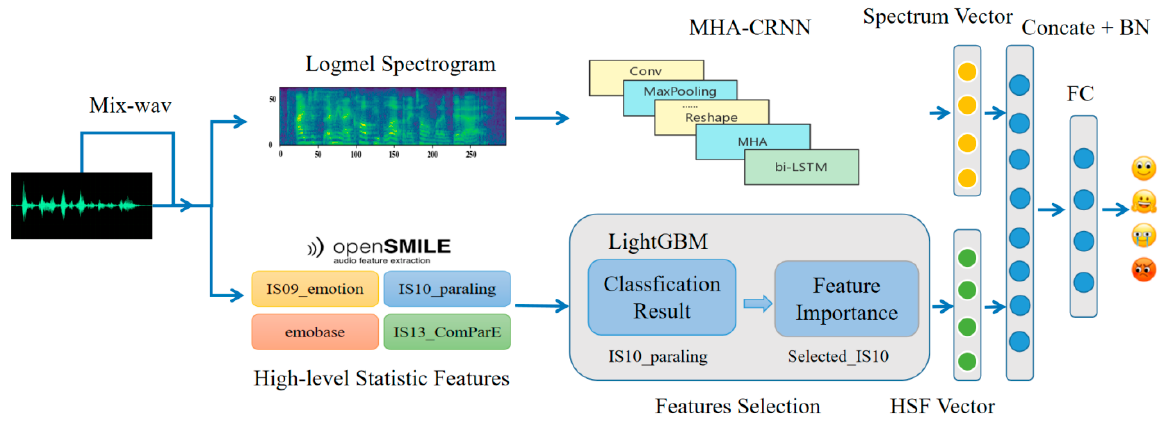
Figure 1. Proposed method. Includes data enhancement, feature extraction, global feature selection, feature fusion and